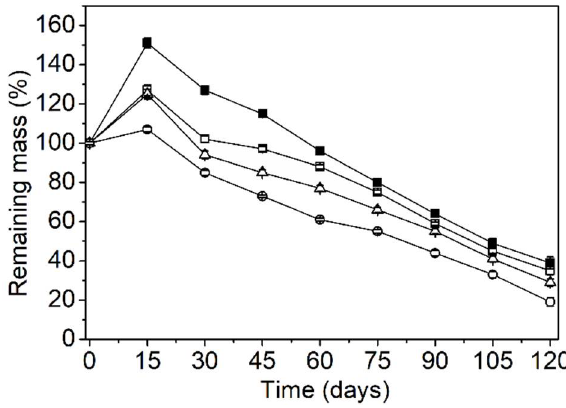
Figure 6. Remaining mass for TPS (closed squares), TPS with GO incorporated at 0.5 mass% (squares), 1.0 mass% (triangles) and 2.0 mass% (circles) during biodegradation in soil for 120 days.